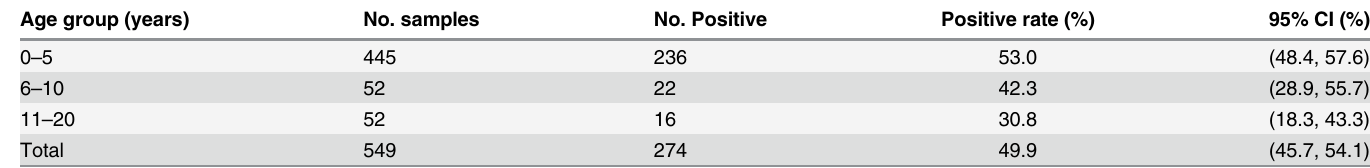
Table 2. Age-specific EV71 seroprevalence (EV71-IgG) in healthy children of Zhejiang Province, China. Age group